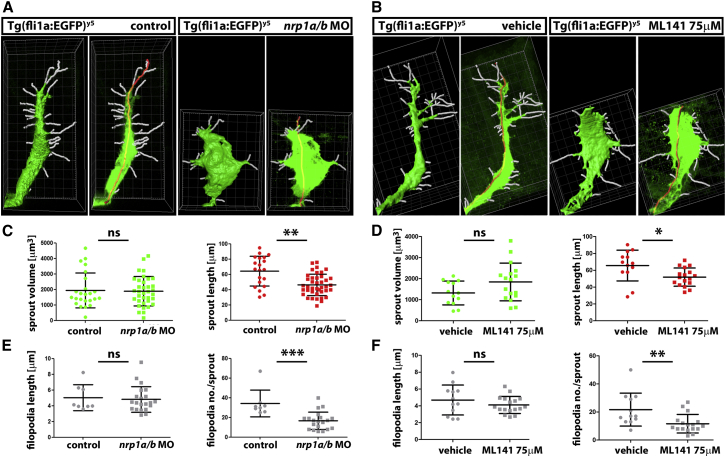
Cdc42 Inhibition Phenocopies Nrp1 Knockdown during Zebrafish Angiogenesis(A and B) Imaris image analysis of ISV sprouts in nrp1 morphant, ML141-treated and control embryos to determine sprout volume via surface rendering (left panel for each condition) and filament tracing to determine sprout length (red line in the right panel for each condition) and filopodia number as well as filopodia length (white lines). Grid ticks, 1 μm.(C–F) Quantitative analysis of the Imaris images exemplified in (A and B) for sprout volume and sprout length (C and D), filopodia length and filopodia number (E and F); mean ± SD, n ≥ 8 sprouts for nrp1 morphant relative to control treated fish (C and E) and ML141- versus vehicle-treated fish (D and F); asterisks indicate ∗p < 0.05, ∗∗p < 0.01, ∗∗∗p < 0.001, and ns > 0.05.